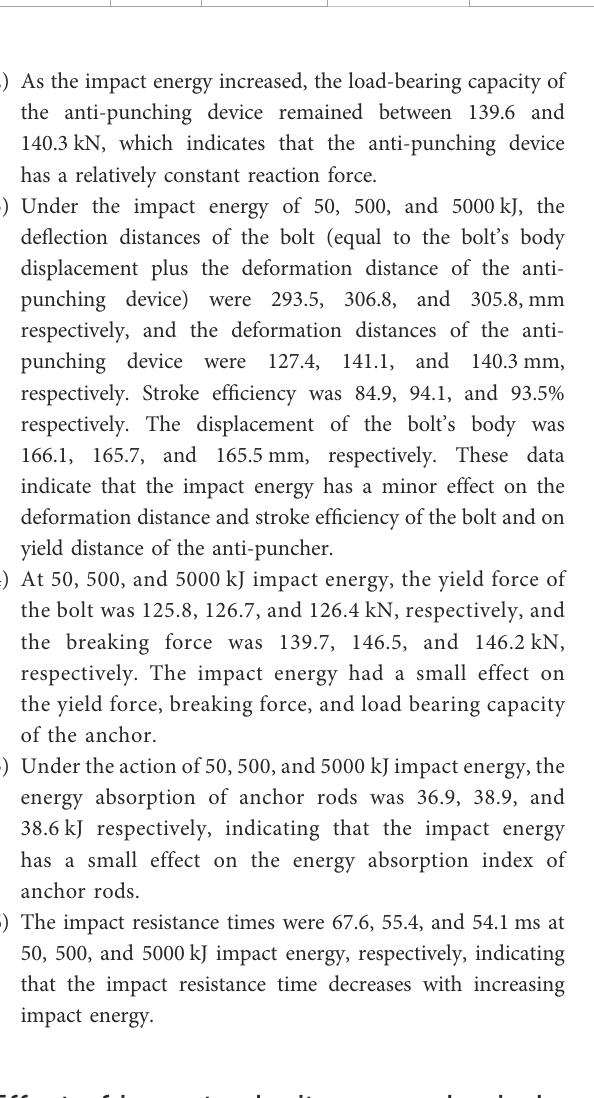
Figure 14, the energy absorption-displacement is shown in Figure 15, and the mechanical properties of the anchor rod are shown in Table 4. From Figures 13 – 18 and Table 4, it can be seen that: